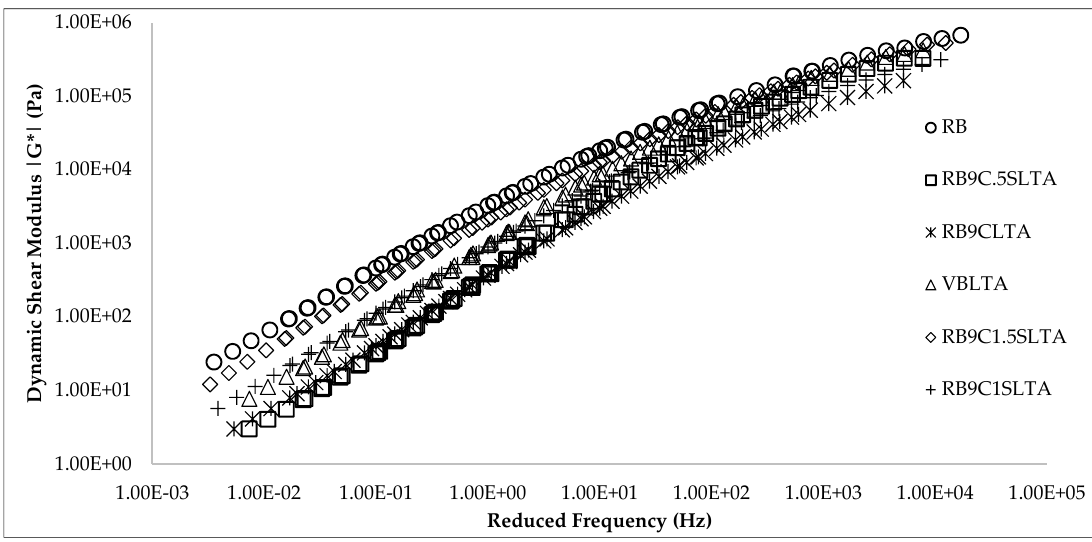
Figure 10. Effect of rejuvenation and aging on the master curve of binders. Figure 10. E ff ect of rejuvenation and aging on the master curve of